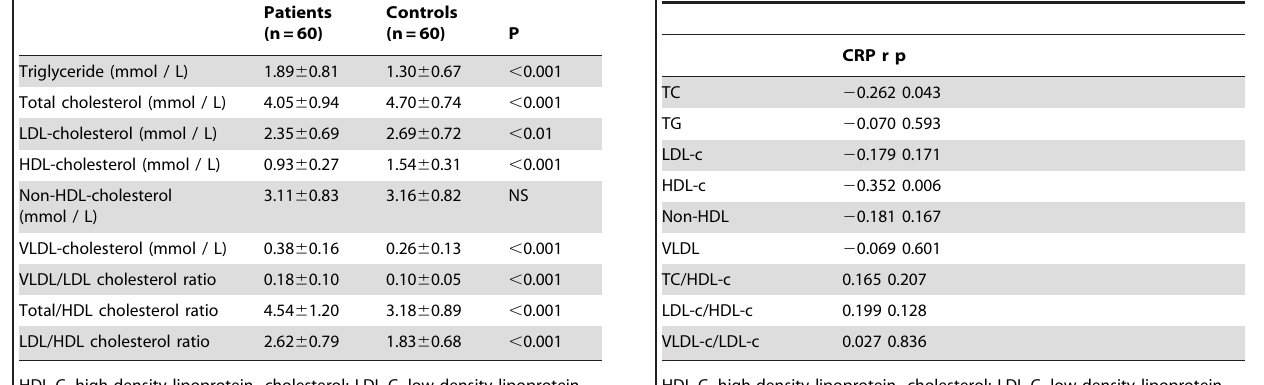
Table 3. Correlation between CRP and lipid profiles among untreated patients with early